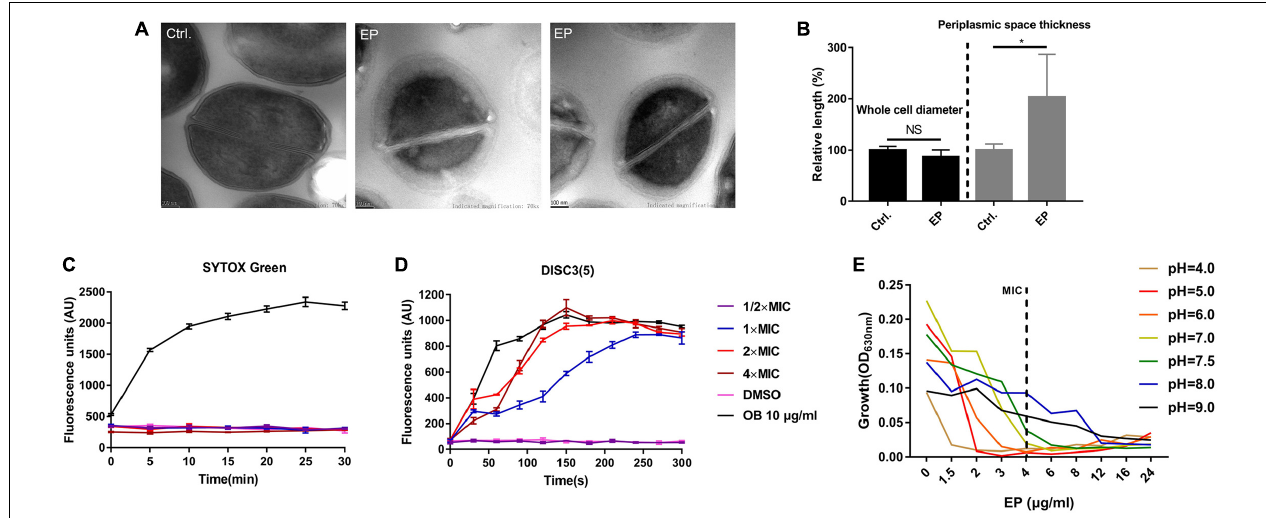
FIGURE 3 | Disruption of proton motive force by EP. (A) TEM showed edema formation in EP treated cells. S. aureus USA300 was treated with EP at 5 × MIC for 1 h. After washing with phosphate-buffered saline, samples were fixed with 2.5% glutaraldehyde and subject to further TEM observation. (B) Relative length of bacterial cell diameters and periplasmic space thickness after treatment with EP. The calculation was based on TEM observations. (C) Bacterial cell membrane integrity detection by SYTOX Green staining. OB (otilonium bromide, 10 µ g/mL) was used as the positive control. (D) Effects of EP on bacterial cell membrane potential stability by DiSC3(5) staining. OB (10 µ g/mL) was used as the positive control. (E) Growth inhibition by EP against S. aureus USA300 in pH-adjusted MH broth. Shown is the mean of three biological